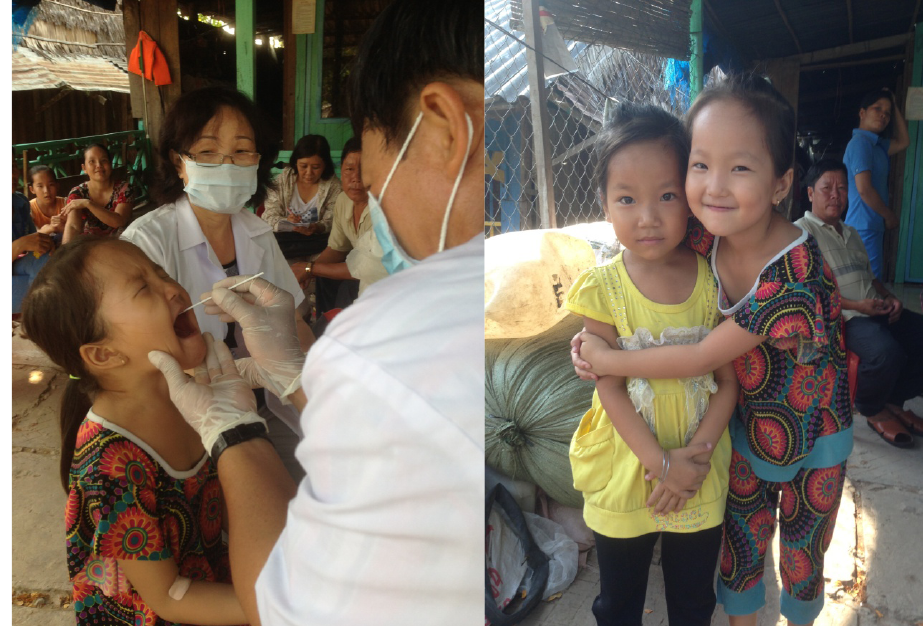
Figure 1: Enrolment